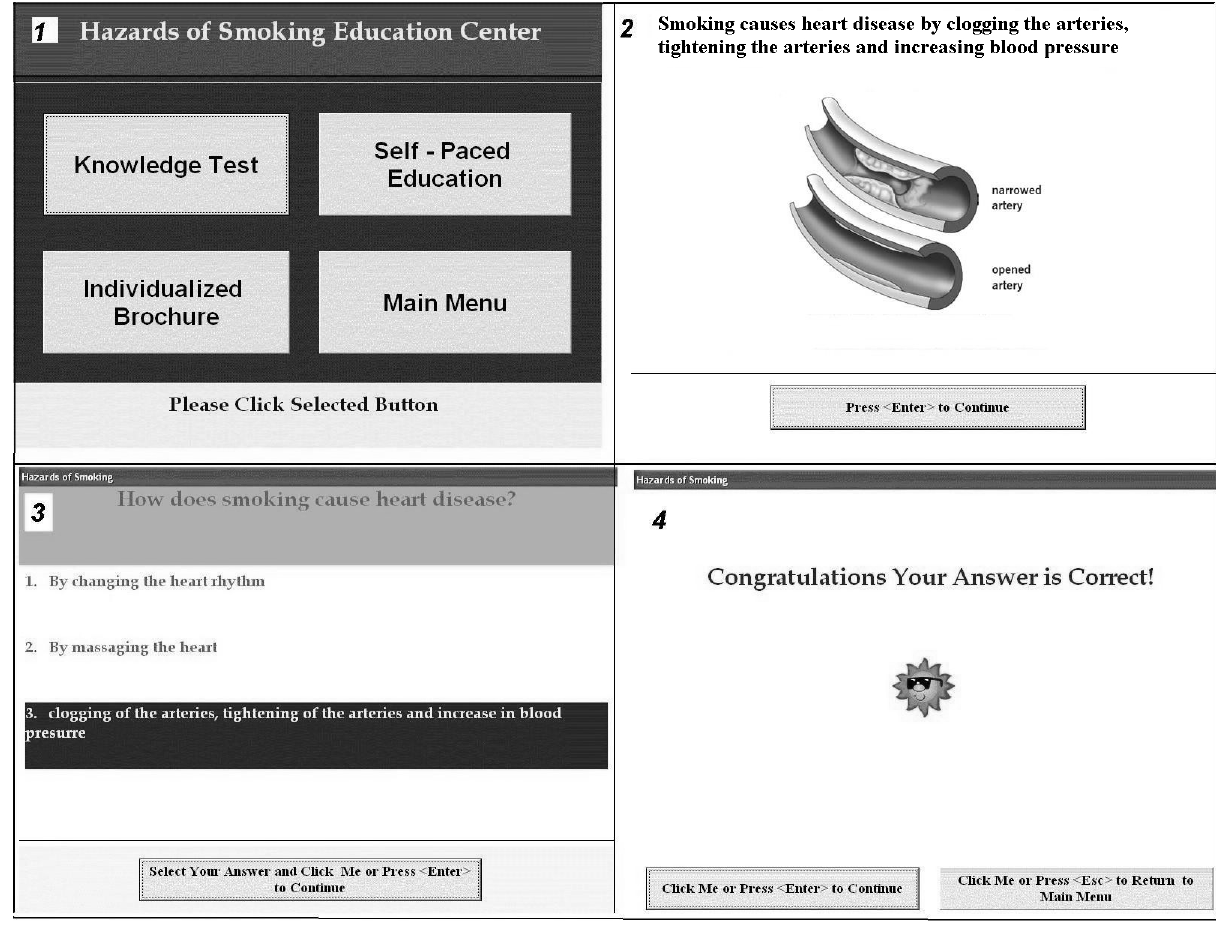
Figure 1. Selected screens of the computer program used in the study: (1) the start screen of the program; (2) educational message; (3) multiple-choice question; and (4) correct answer